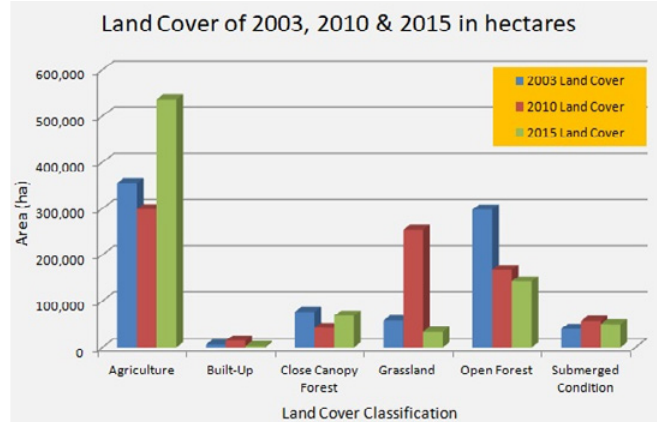
Fig. 5: Land cover of 2003, 2010 and 2015 in ha